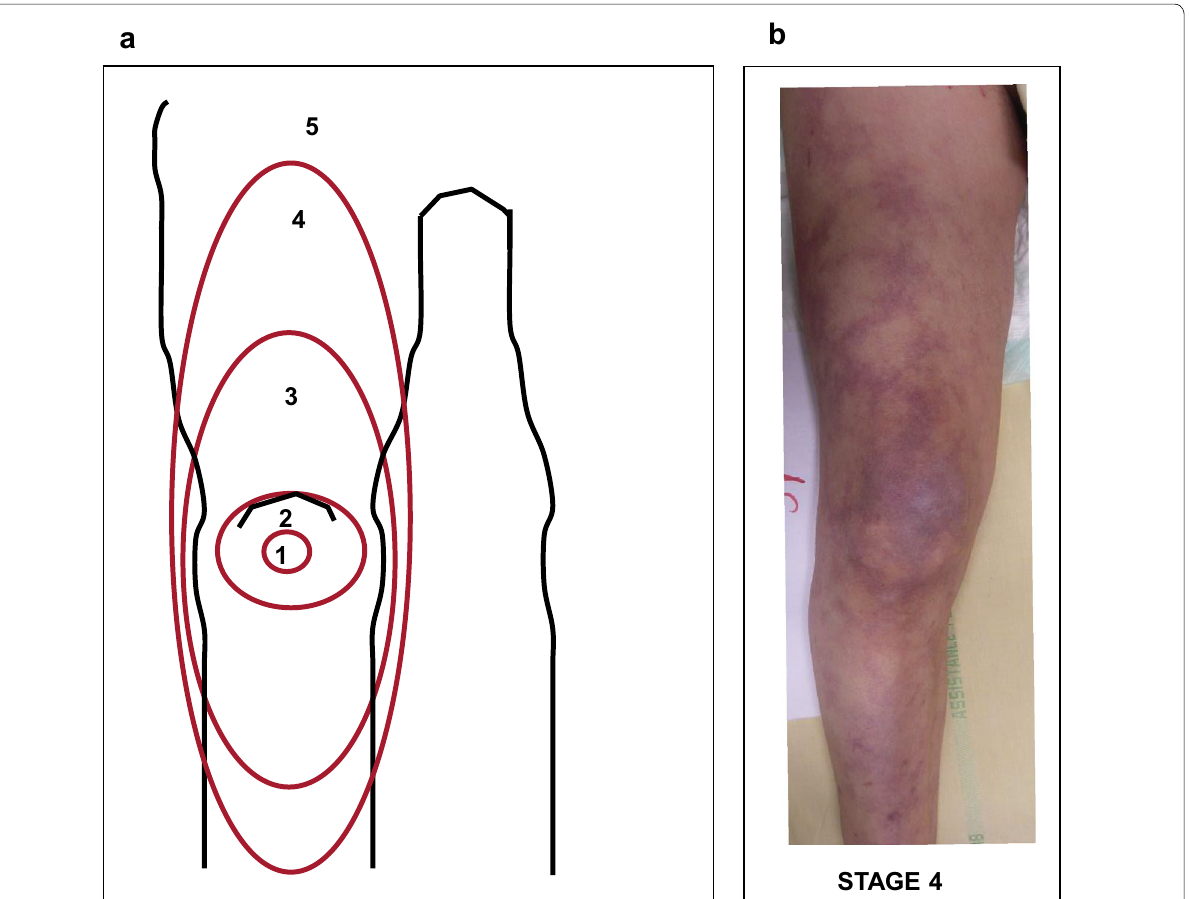
Fig. 4 a The mottling score, ranging from 0 to 5, is based on skin mottling area extension on legs. Score 0 represents no mottling, score 1 represents small mottling area (coin size) localized to the center of the knee, score 2 represents mottling area not exceeding the superior edge of the knee cap, score 3 represents mottling area not exceeding the middle thigh, score 4 represents mottling area not exceeding the fold of the groin and score 5 otherwise. b Example of mottling score 5. Adapted from